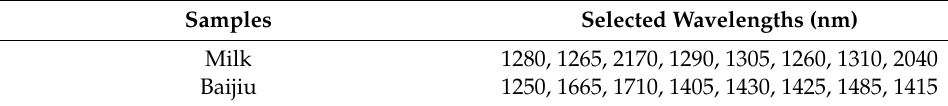
Table 6. Results of feature wavelength selection.